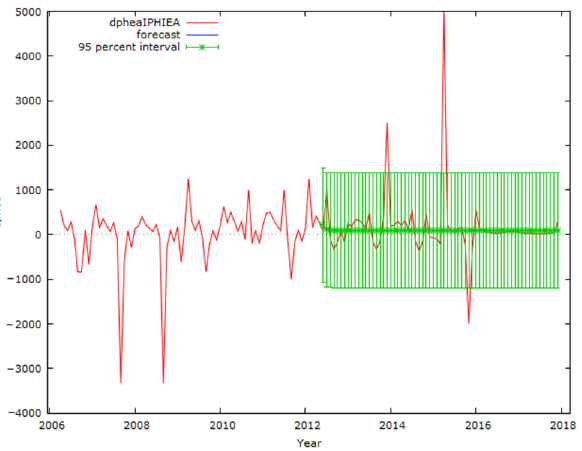
Figure A6. Time series forecasting for dphea, the in-sample January 2000–May 2012, and the out-of-